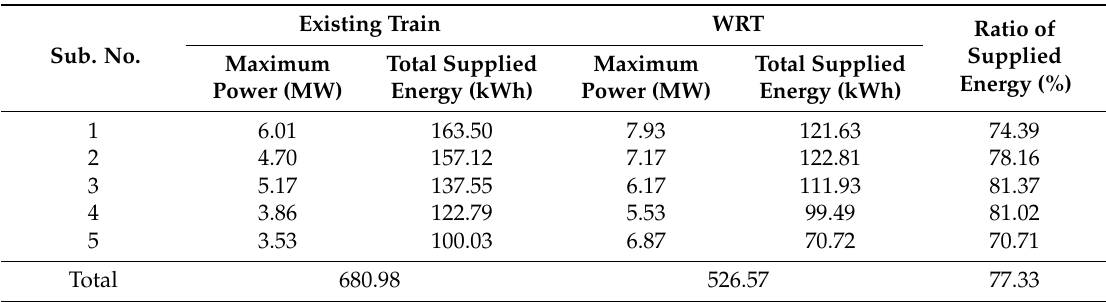
Table 5. Power simulation results for railway substation at non-peak headway condition.